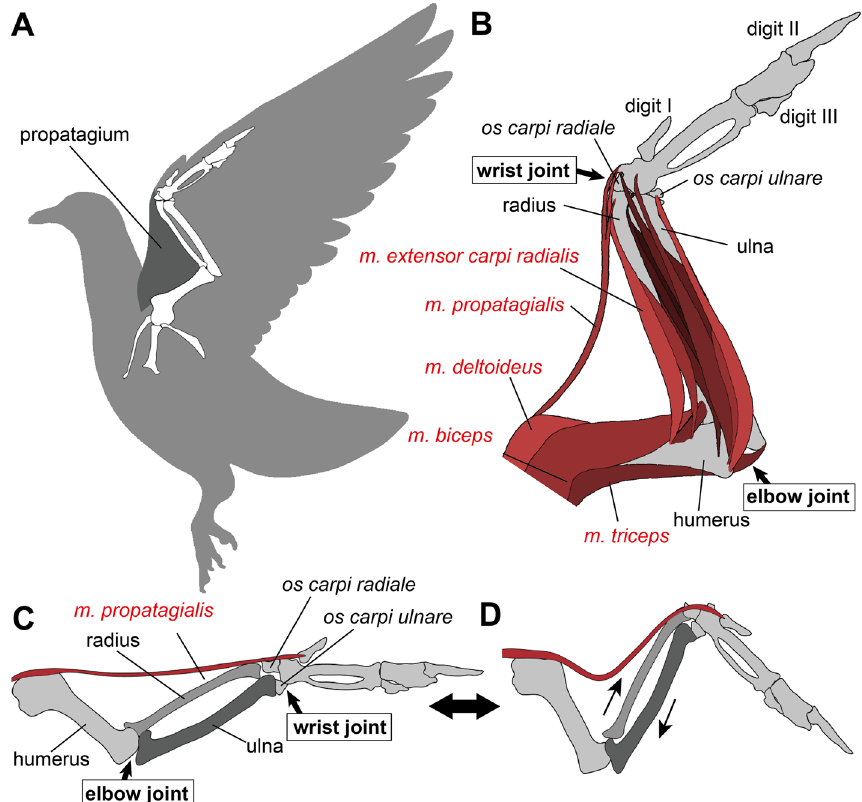
Fig. 1 Musculoskeletal system of the avian left wing in ventral view. A , B , Propatagium ( A ) and forelimb muscles ( B ). C , D , Synchronous actions between the elbow and wrist joints, at an extension via the function of the musculus (m.) propatagialis ( C ) and at a flexion via the interlocking wing-folding system ( D